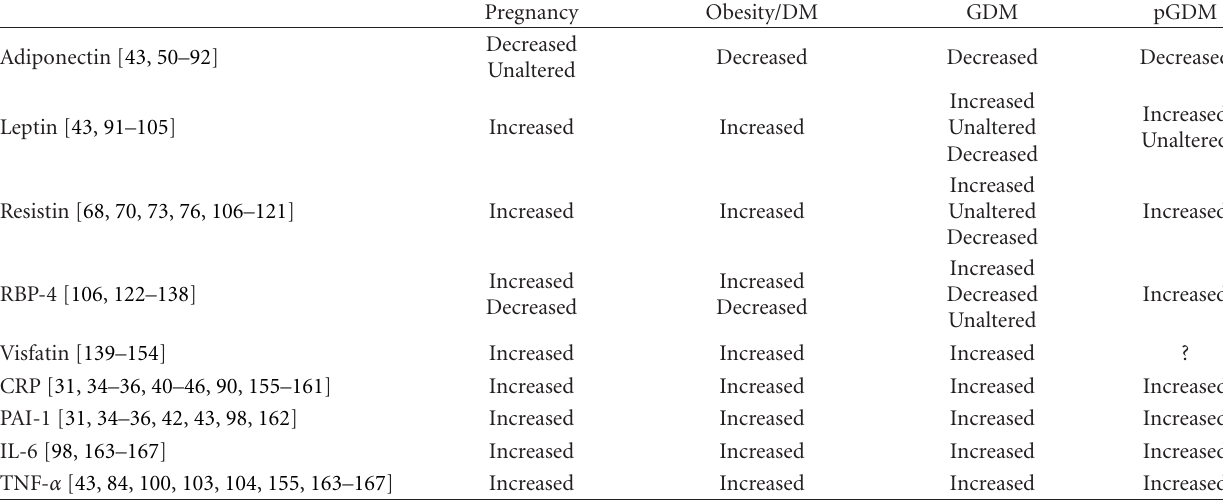
Table 1: Adipokines and other inflammatory mediators in normal pregnancy, obesity/DM, GDM, and